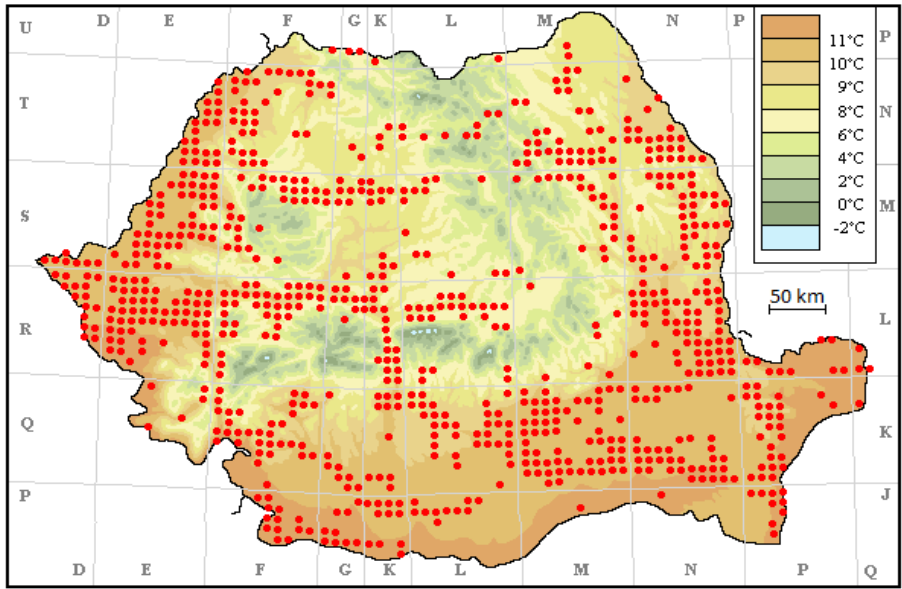
Figure 1. The map of Ambrosia spread in Romania between 1908–2012 (Culita Sirbu, 2012, original work, unpublished, reproduced with author’s permission), completed with mean annual temperature by Sorin Stefanut (UTM system, 10 × 10